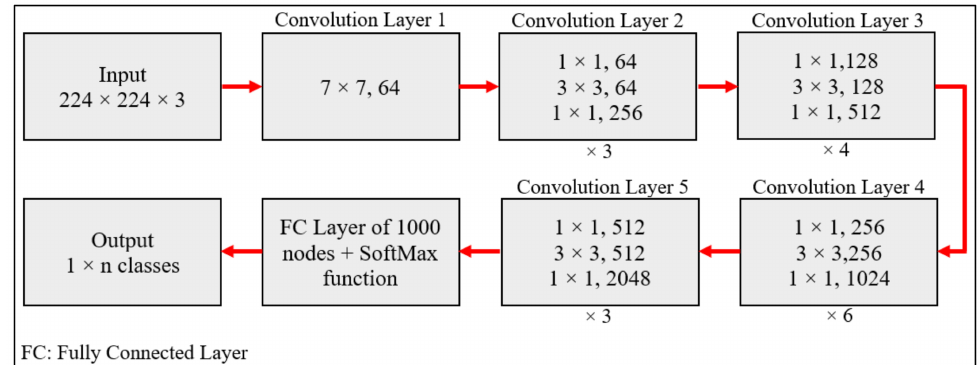
Figure 6. ResNet-50 layered architecture from